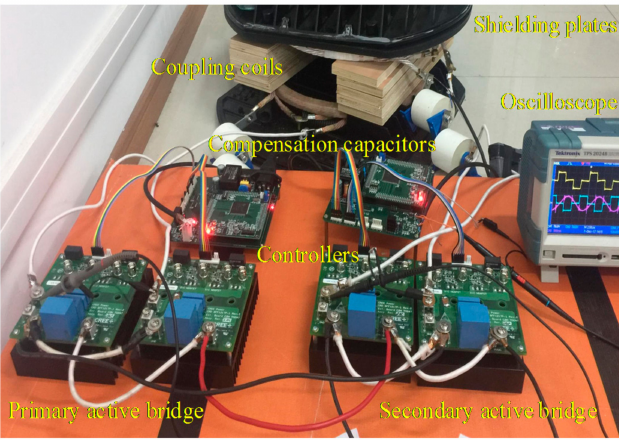
Figure 9. Prototype photograph of the DAB WPT